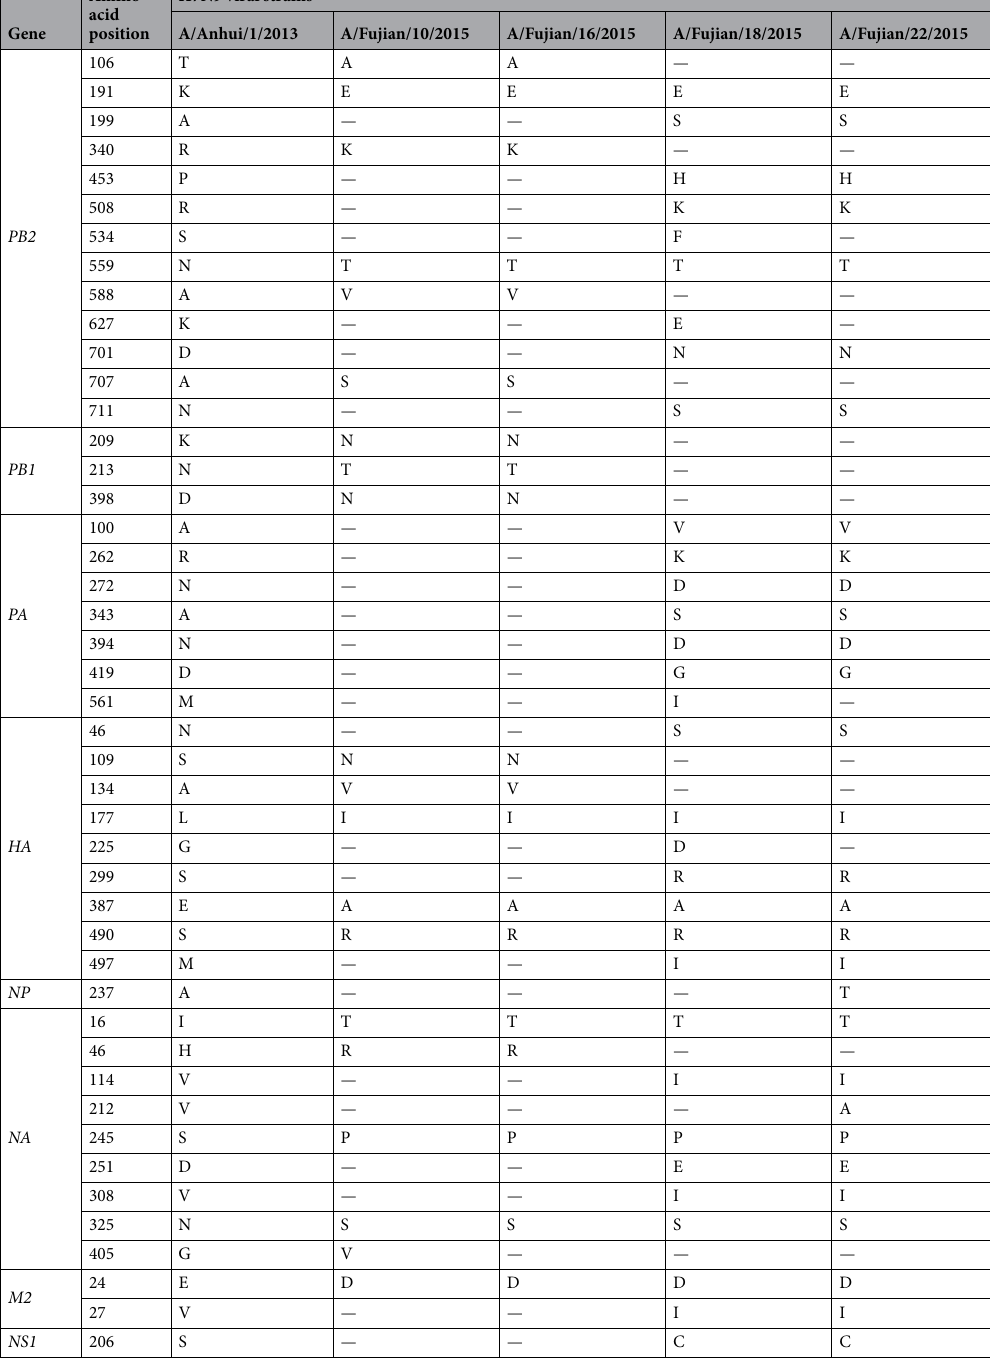
Table 3. Amino acid substitutions in H7N9 virus from the family clusters. Note. The HA gene was under the H3 numbering system and the NA gene under the N2 numbering system. Other internal genes were numbered from the start codon